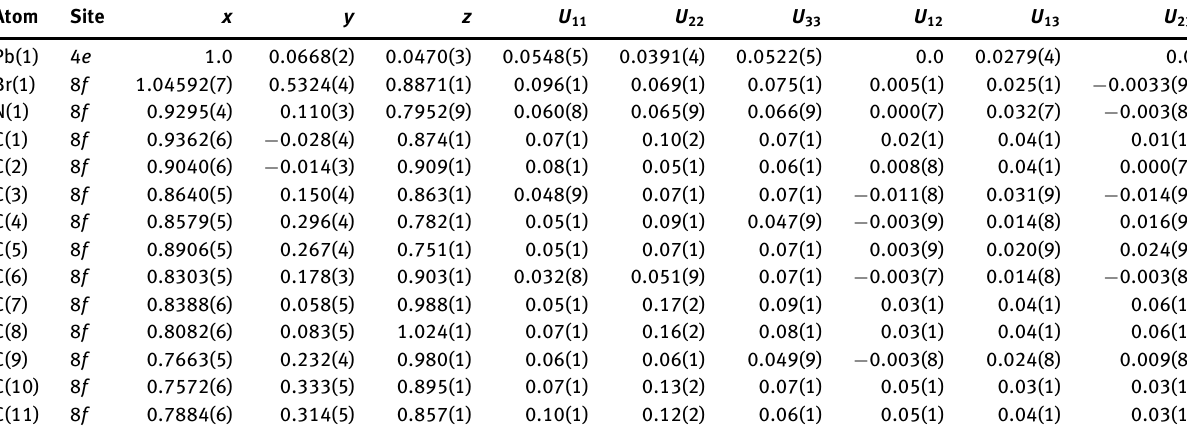
Table 3: Atomic displacement parameters (Å 2